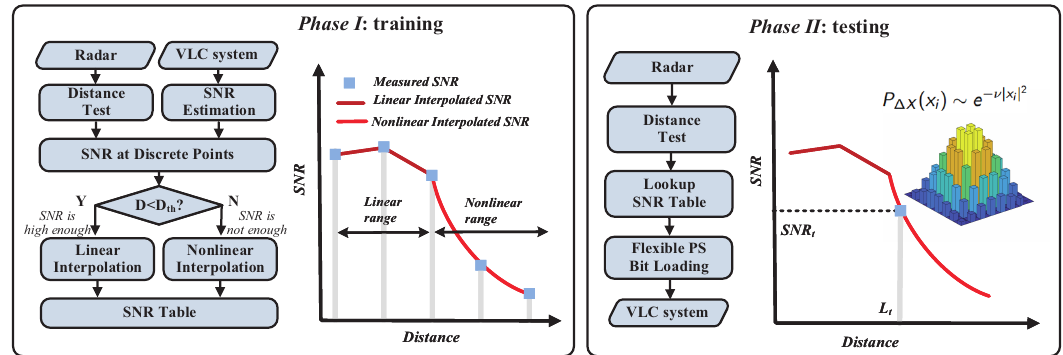
Figure 1. The process of the VLC-Radar fusion V2X